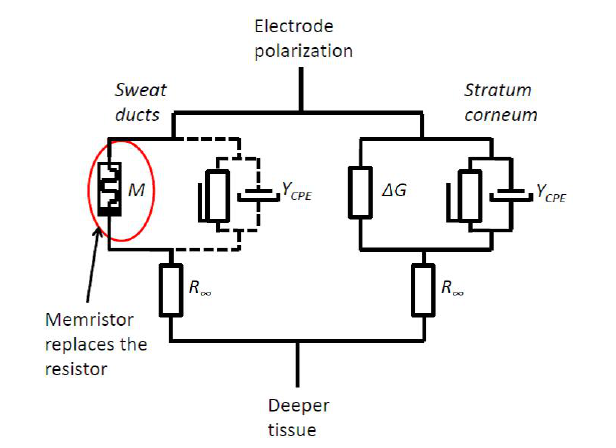
with the memristor to capture the sweat duct